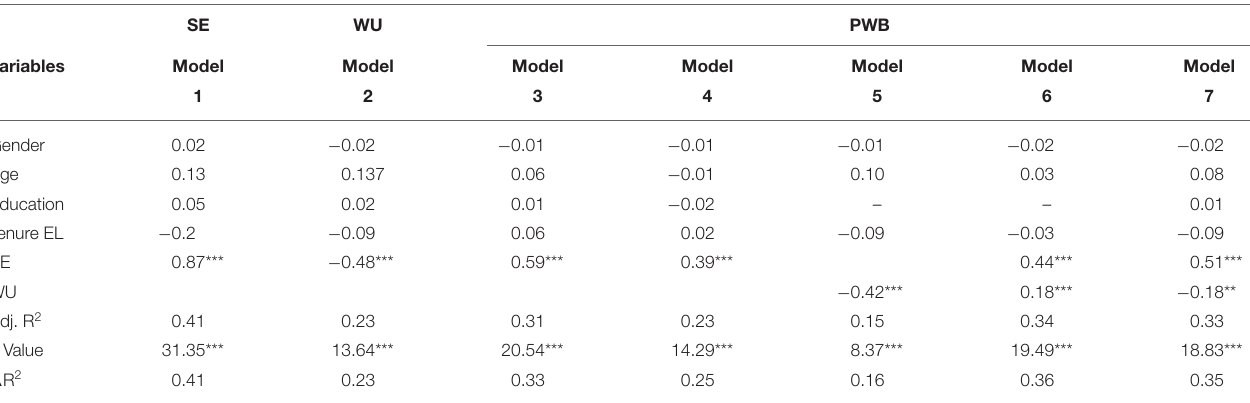
TABLE 2 | Hierarchical regression